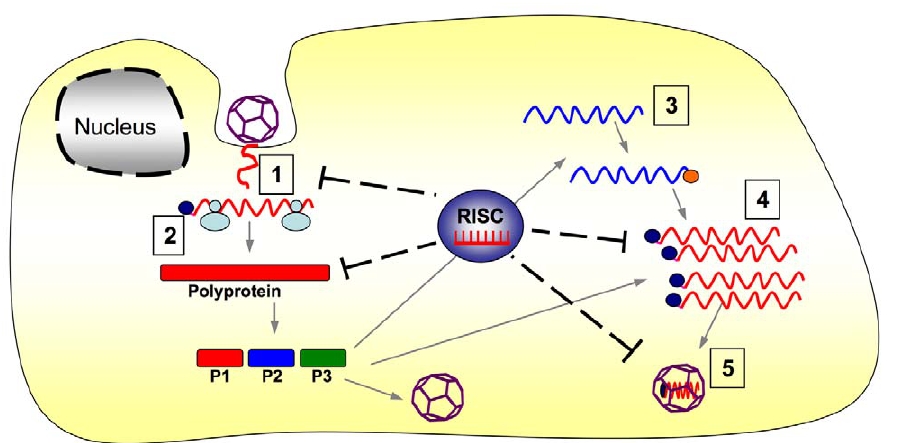
Figure 5. RISC-mediated inhibition of CVA21 life cycle. Stages in the picornaviral life cycle at which miRNAs could potentially act: 1-genome attack after uncoating; 2-polyprotein translation; 3-negative strand RNA synthesis; 4- positive strand RNA accumulation;